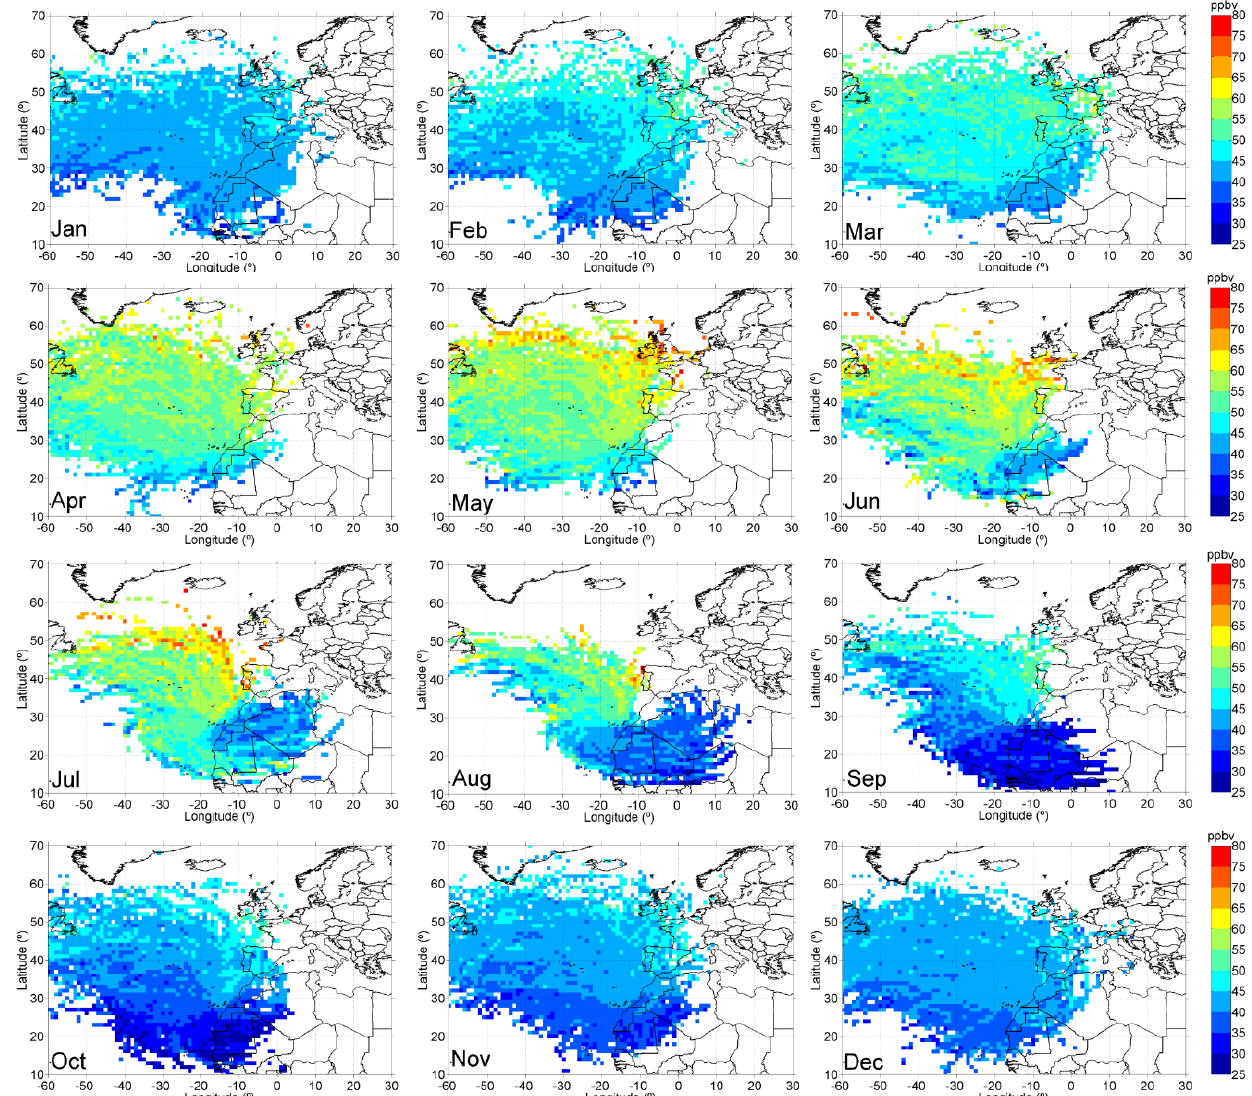
Fig. 5. Surface O 3 MCAR plots for each month of the year for the period 1988–2009. Color bars indicate O 3 concentration in ppbv.